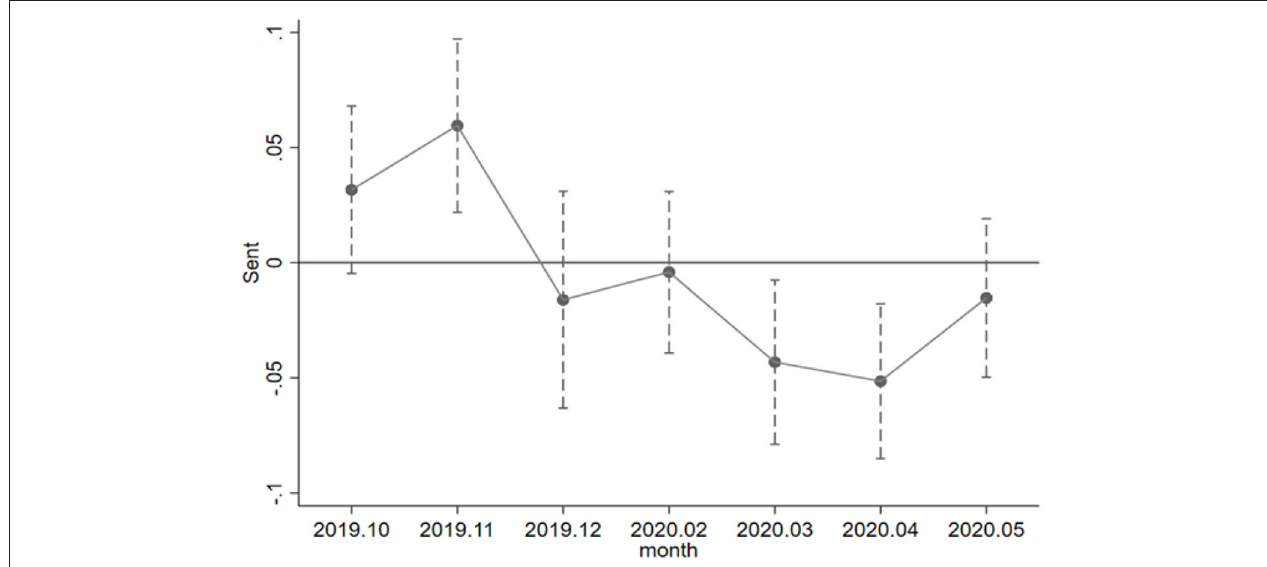
FIGURE 1 | Parallel trend